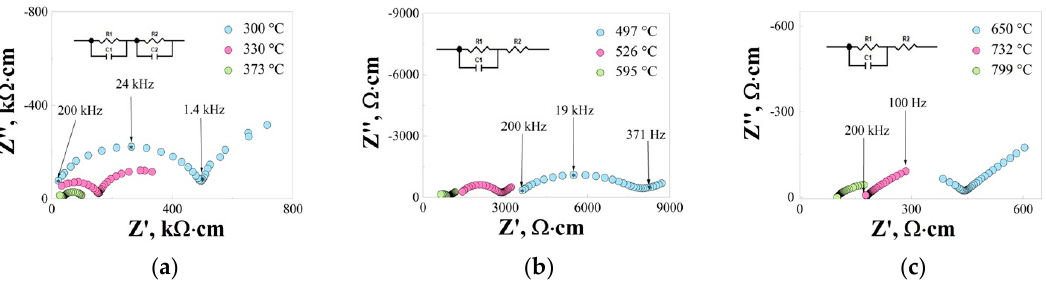
Figure 5. Impedance hodographs of 0.95Gd 2 Zr 2 O 7 -0.05MgO obtained in air in the temperature ranges of ( a ) 300–373 ° С , ( b ) 497–595 ° С , and ( c ) 650–799 ° С .